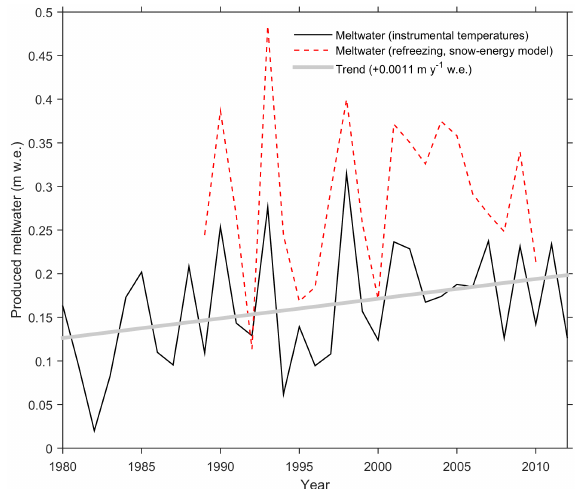
Figure 13. Produced meltwater calculated at Lomonosovfonna us- ing the PDD (black) and snow–energy model (dashed red) ap- proaches. The linear trend of meltwater calculated with the PDD ap- proach and instrumental temperatures is also shown over the 1979– 2012 period (grey).